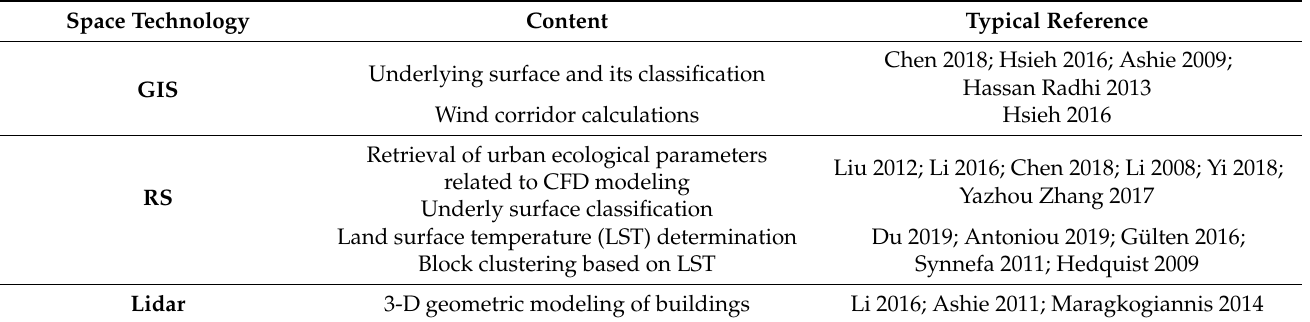
Table 3. Combinations of CFD and space technologies applied to analyze USTEs.